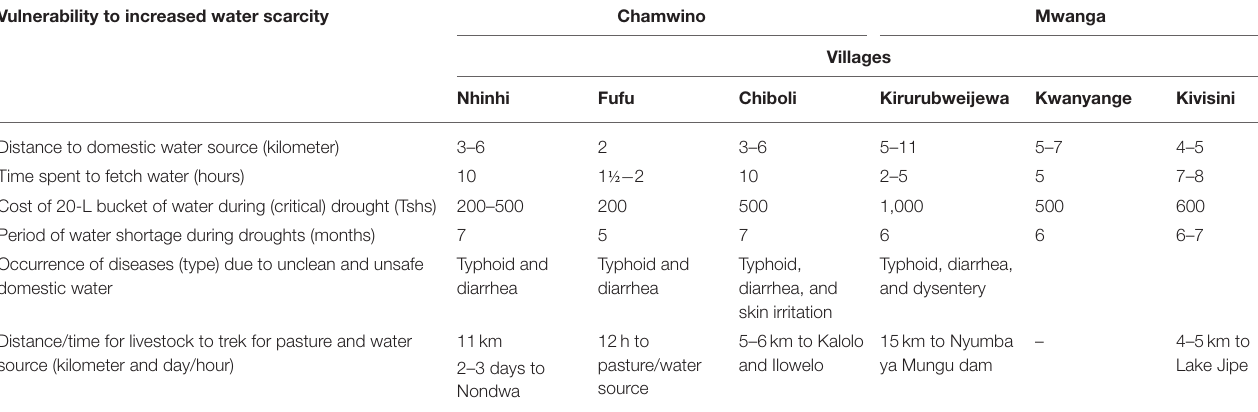
TABLE 3 | Vulnerabilities to water scarcity for domestic and livestock drinking during